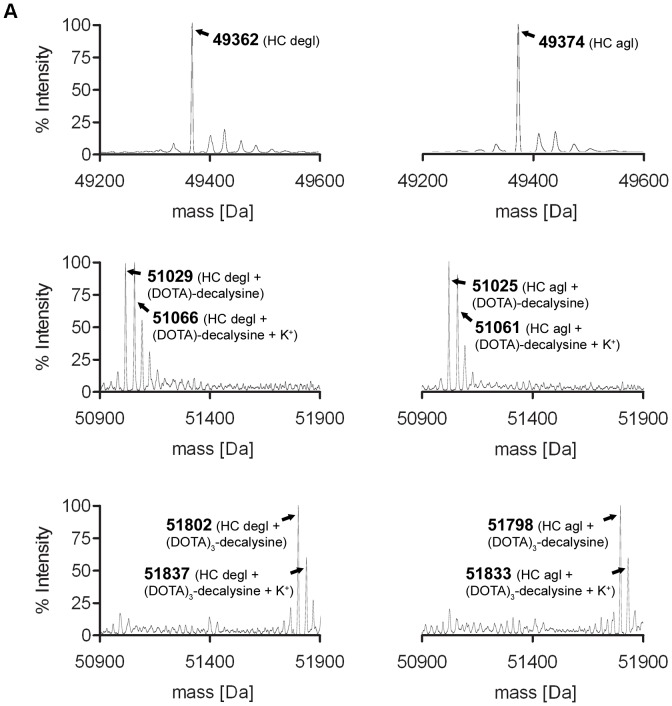
LC-ESI-TOF mass spectrometry analysis of the heavy chain (HC) of the used antibodies.Deconvolution of the raw data was accomplished by MaxEnt1. A. Mass spectrum of HC for chCE7degl (left) and chCE7agl (right). B. Mass spectrum of HC for chCE7degl coupled to (DOTA)-decalysine (left) and chCE7agl coupled to (DOTA)-decalysine (right); C. Mass spectrum of HC for chCE7degl coupled to (DOTA)3-decalysine (left) and chCE7agl coupled to (DOTA)3-decalysine (right).